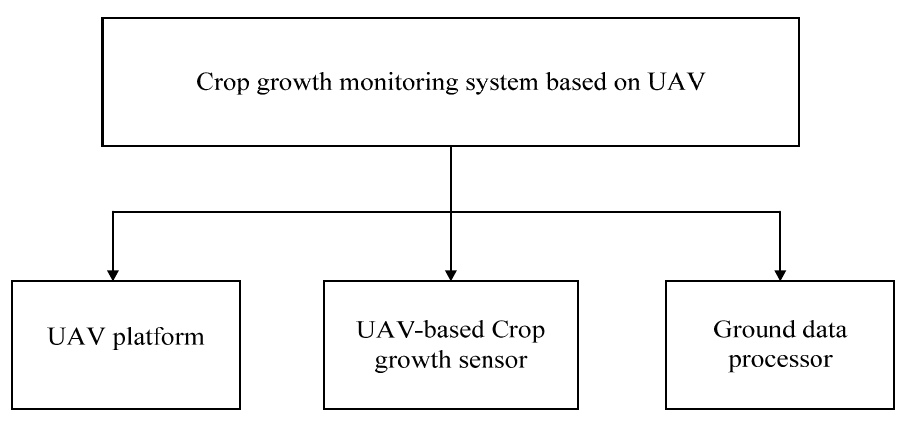
Figure 1. The structure of the UAV-borne crop-growth monitoring system.